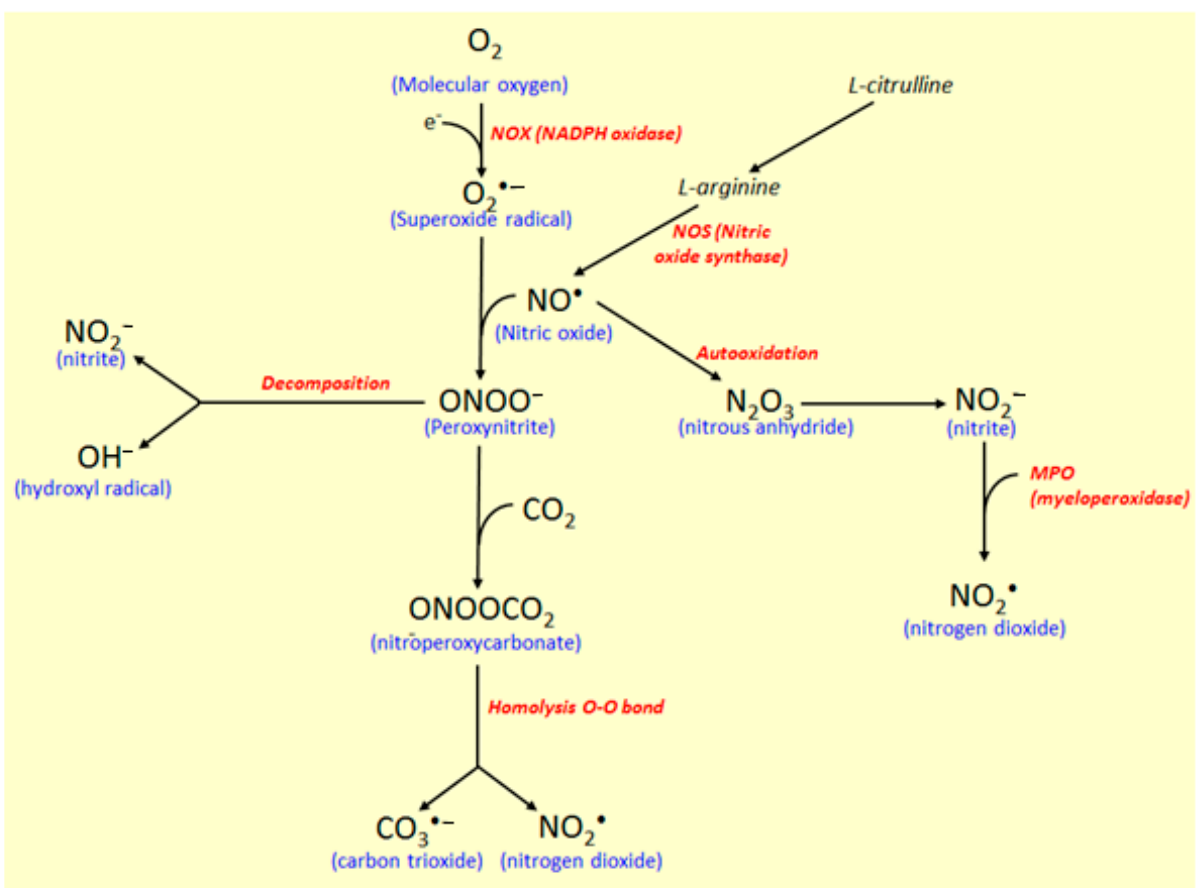
Figure 6. Nitric oxide synthase (NOS) pathway of free radical production. NOX, NADPH oxidase; NOS, nitric oxide synthase; MPO, myeloperoxidase. In these oxidative processes, the following activities were reported: A. Inhibition of iNOS activity by paepalantine, esculetin, esculin, auraptene, and collinin; B. Reduction of NO release by isomeranzin and esculin.